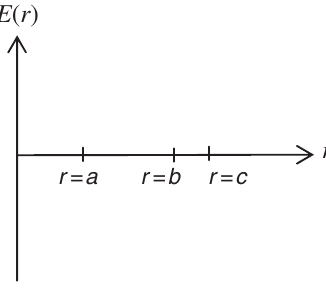
FIG. 2. Coordinate axes provided to all students for plotting the electric field in part